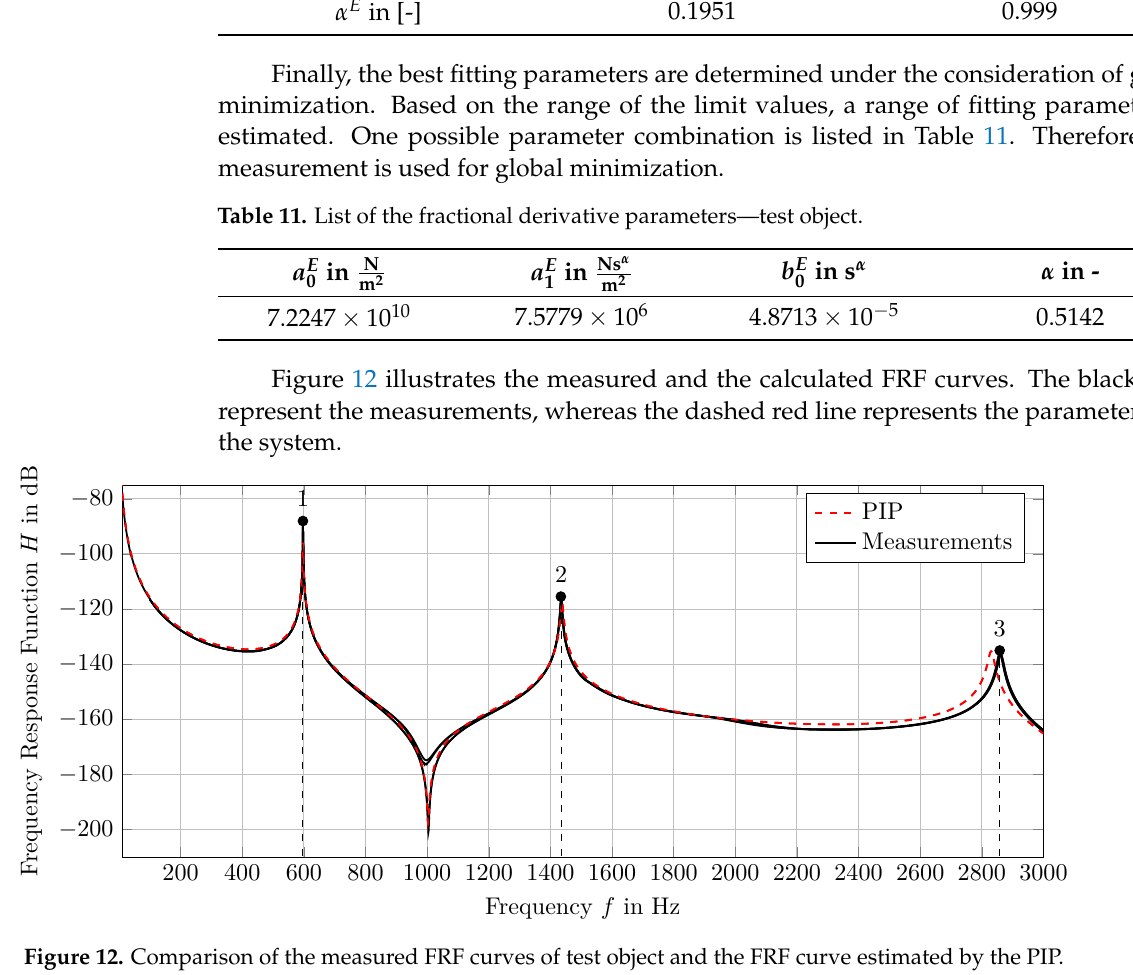
Figure 12. Comparison of the measured FRF curves of test object and the FRF curve estimated by the PIP. The quality of the modeling process is shown by the accuracy of the anti-resonance around 1000 Hz. The value of a E is similar to the value listed in the literature [46] 0